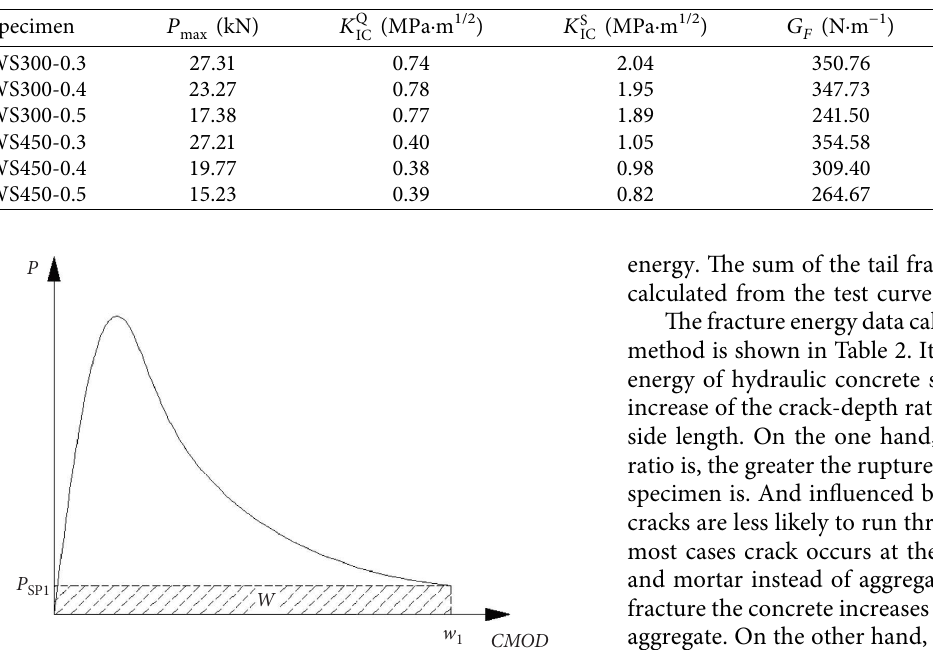
Table 2: Te fracture parameters of hydraulic concrete.